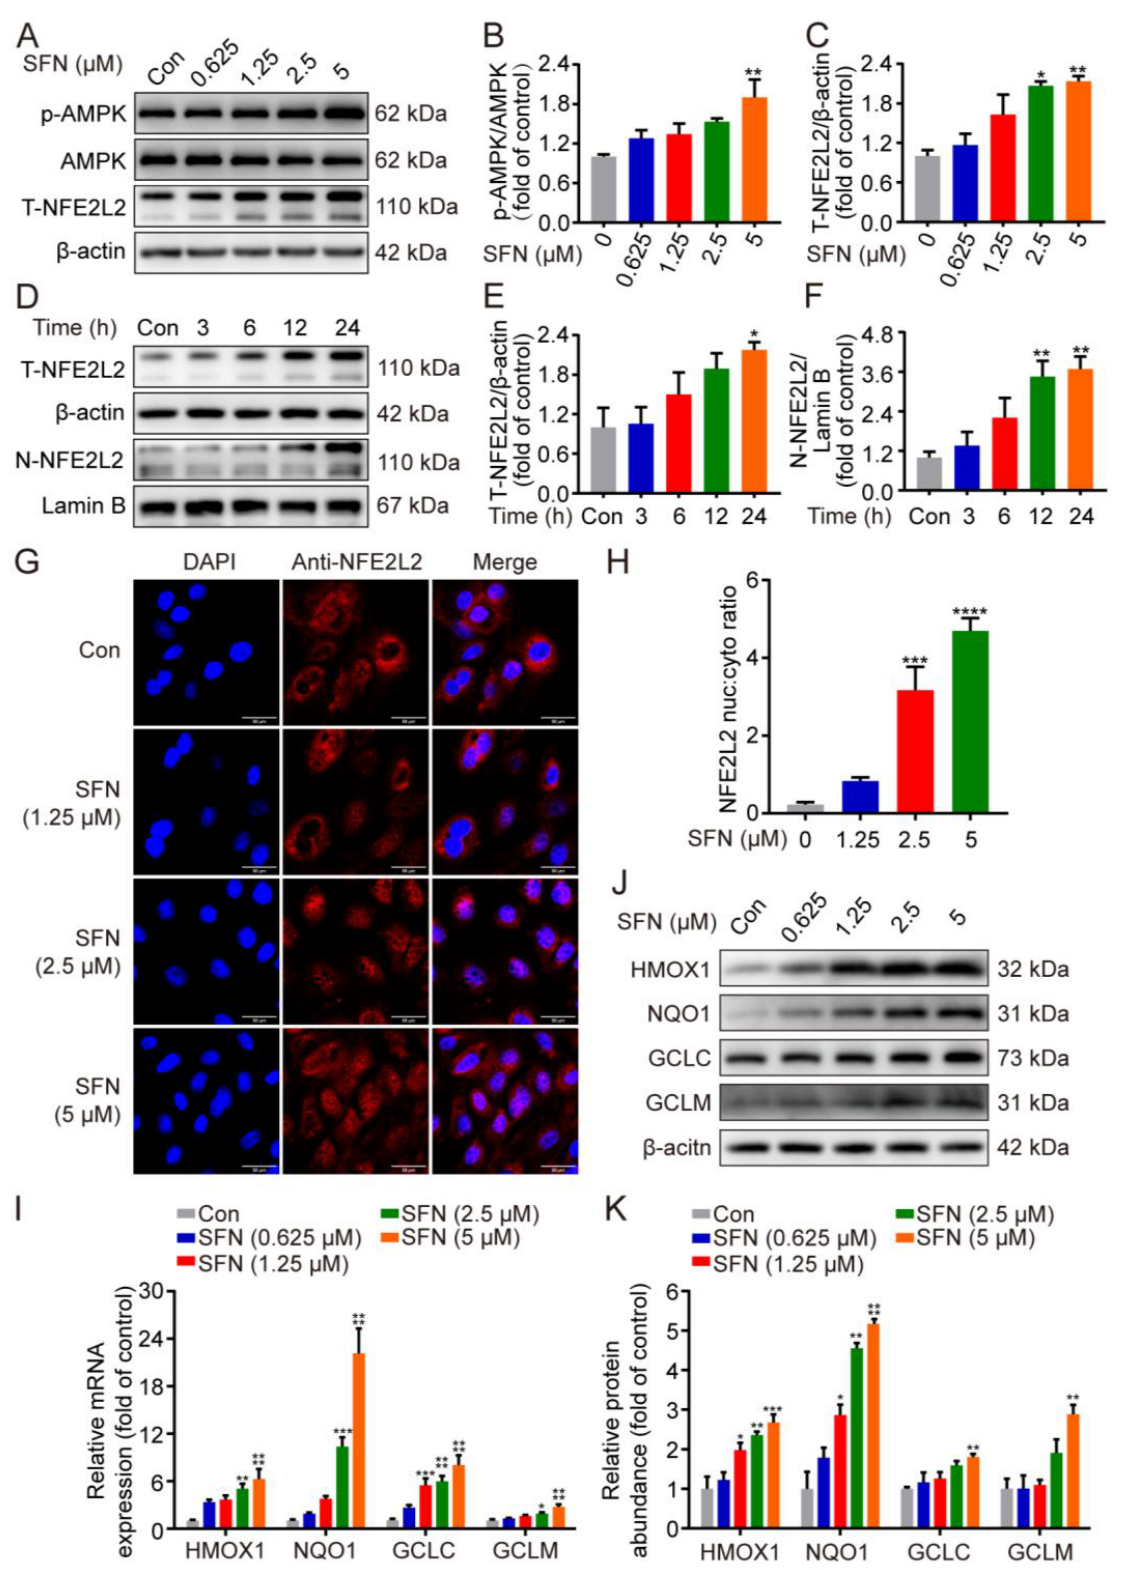
Figure 3. SFN accelerated AMPK phosphorylation, promoted NFE2L2 nuclear translocation, and upregulated antioxidant enzyme expression in primary GMECs. ( A ) Phosphorylated (p)-AMPK and total NFE2L2 (T-NFE2L2) protein levels in total cell lysates were determined by Western blot from